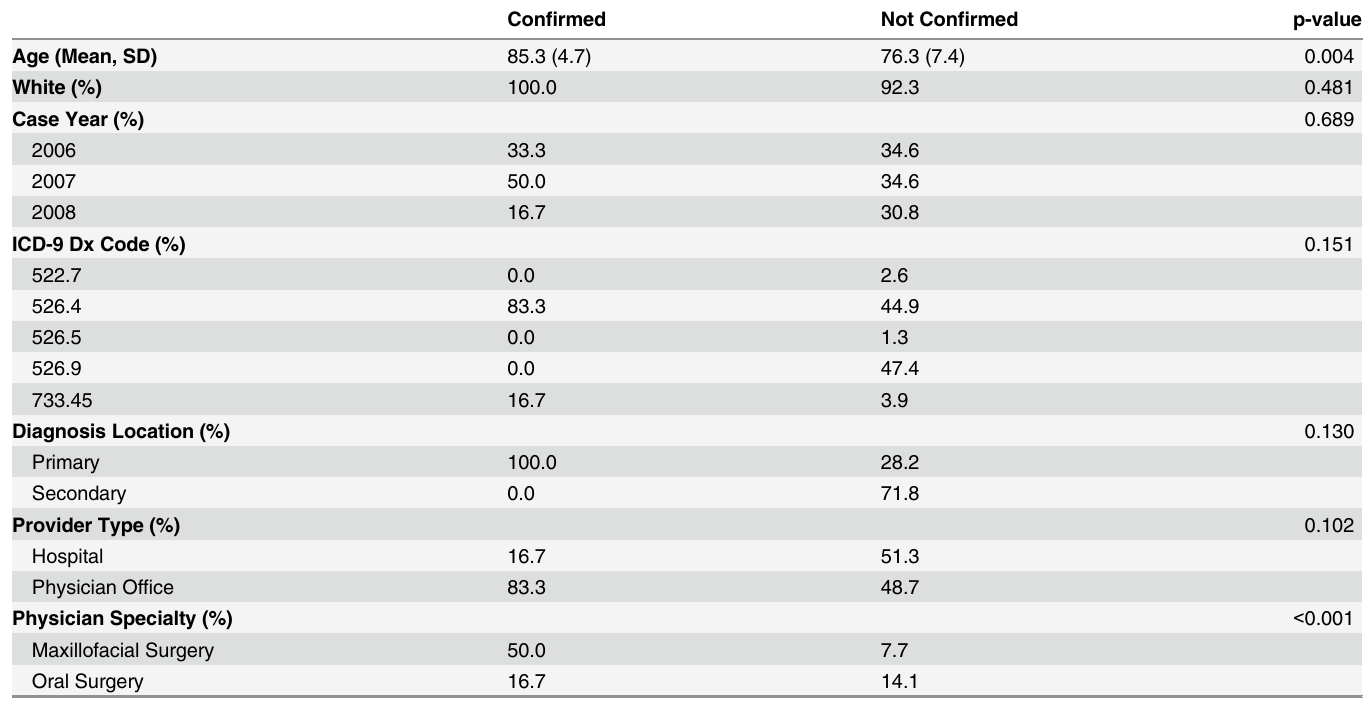
Table 4. Comparison of Characteristics by ONJ Case Determination